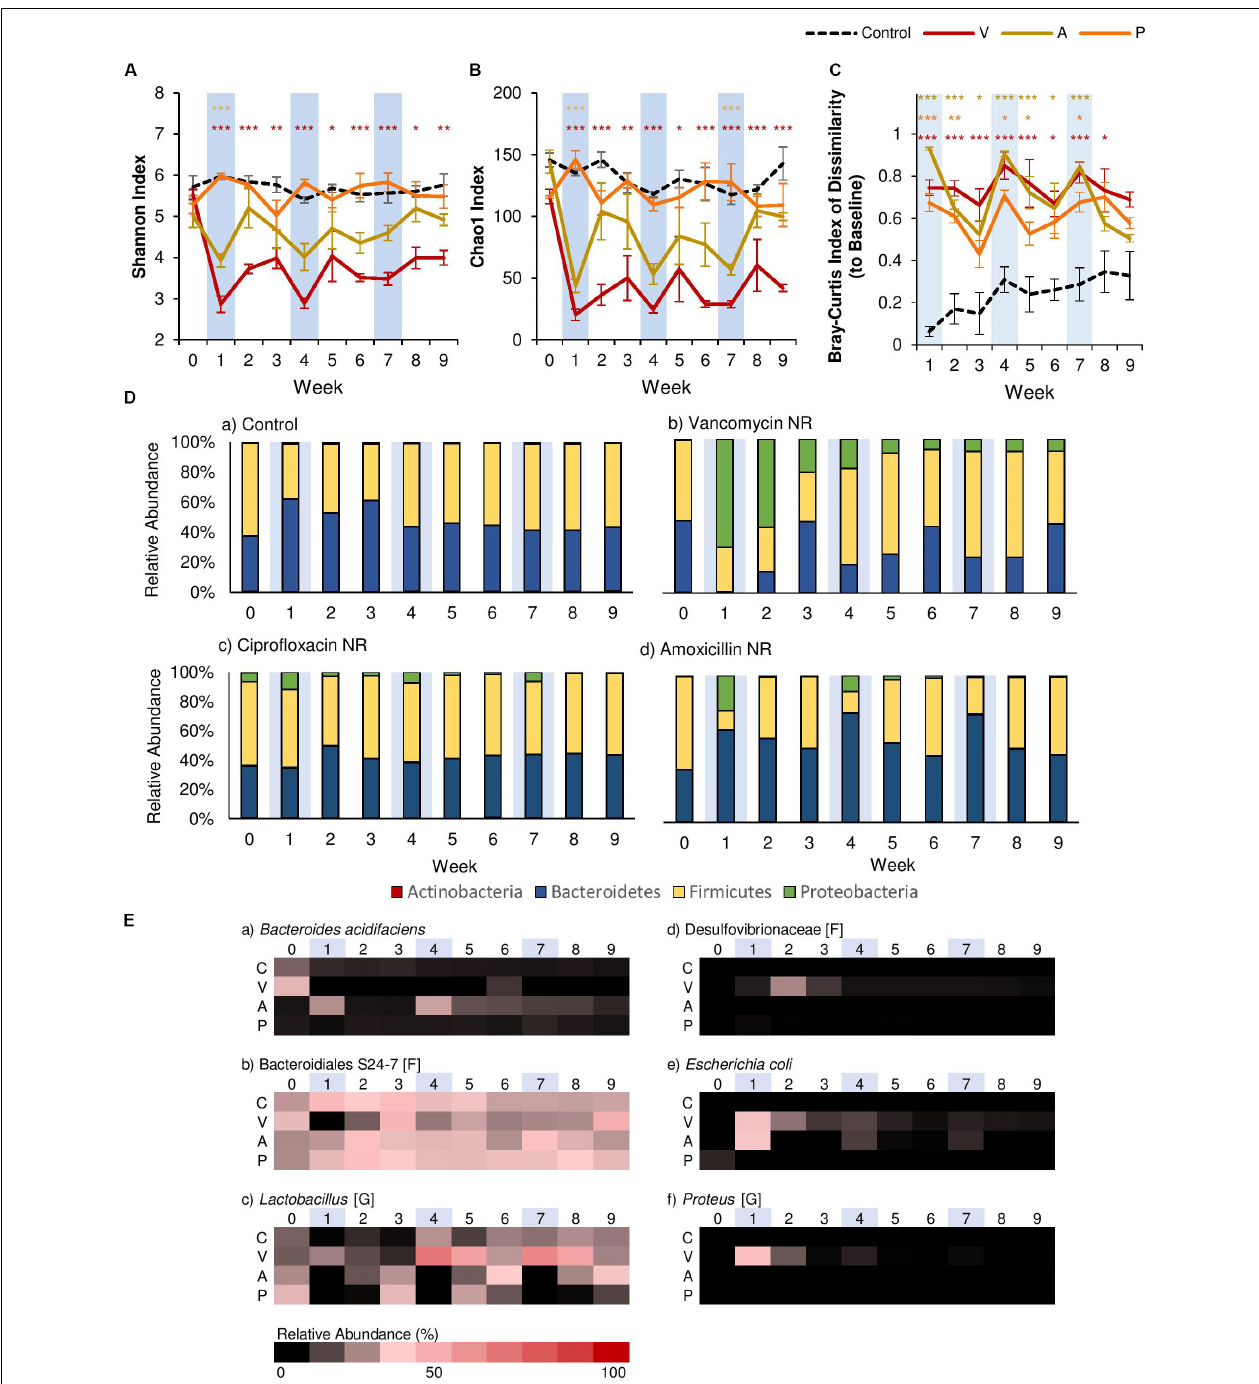
FIGURE 2 | Comparison of the effects of vancomycin, ciprofloxacin, and amoxicillin on the gut microbiome. Each antibiotic was administered for 7 days every 3 weeks, and changes to the fecal microbiome over time were observed by meta-16S rRNA sequencing. Alpha diversity measured by (A) Shannon Index and (B) Chao1 Index for each treatment over time ± standard error. (C) Bray-Curtis Index of Dissimilarity vs baseline for each treatment over time ± standard error. The Bray-Curtis Index was used to quantify the amount of microbial shift from the first day of the experiment (baseline) for each individual. Colored asterisks indicate significance vs control for NR, PR, and FT groups based on Two-Way rm-ANOVA and Tukey’s HSD post hoc test (* p < 0.05, ** p < 0.01, *** p < 0.001). Data for the control samples are indicated as the black dotted line. Natural recovery data for vancomycin is in red, amoxicillin in yellow, and ciprofloxacin in orange. (D) The microbial community at each time point at the phylum level for (a) control, (b) vancomycin, (c) ciprofloxacin, and (d) amoxicillin. (E) Heat map of taxa that significantly changed after antibiotic administration. Significant taxa were identified using factor analysis (factor loading > 0.2). The lowest taxonomic rank for which information was available is indicated in square brackets (F: family, G: genus). Weeks shaded in blue indicate weeks in which antibiotics were administered.